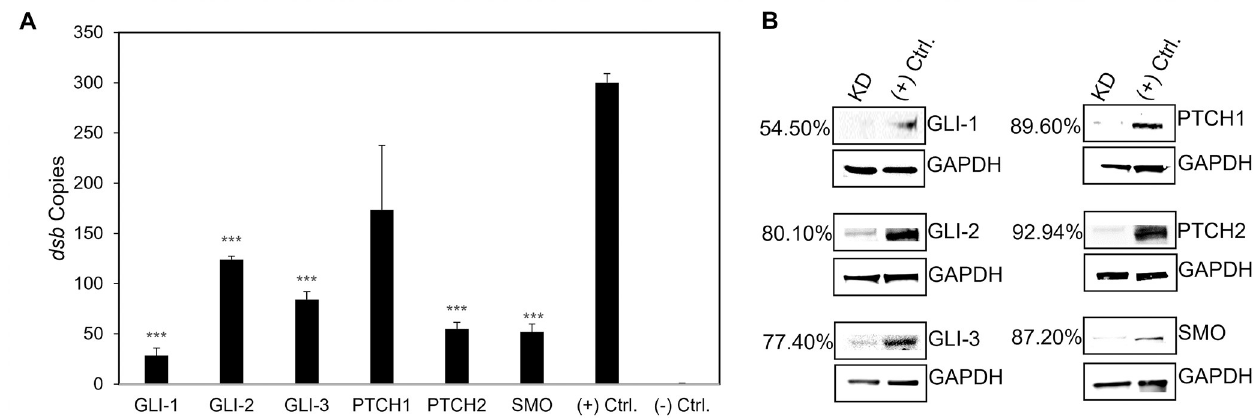
Fig 2. iRNA knockdown of Hh signaling components inhibits E . chaffeensis infection. (A) Small interfering RNA-transfected (siRNA) THP-1 cells were infected or mock infected (-) with E . chaffeensis (MOI 100, 24 h post-transfection). Scrambled siRNA (scrRNA) was transfected for positive (infected) and negative control (mock infected ) . E . chaffeensis infection was quantified at 24 hpi and was determined by qPCR amplification of the dsb gene. siRNA knockdown (KD) of Hh receptors PTCH2, SMO, and transcription factors GLI-1/2/3 significantly inhibits E . chaffeensis infection in THP-1 cells. All knockdowns were performed with at least three biological and technical replicates for t -test analysis. Data are represented as means ± SD ( ��� p < 0.001). (B) Western blot depicts knockdown efficiency of siRNA in knockdown cells compared to positive control from whole-cell lysates harvested 24 hpi. Number left of siRNA lane indicates percent knockdown of protein of interest relative to positive control, normalized to GAPDH expression.